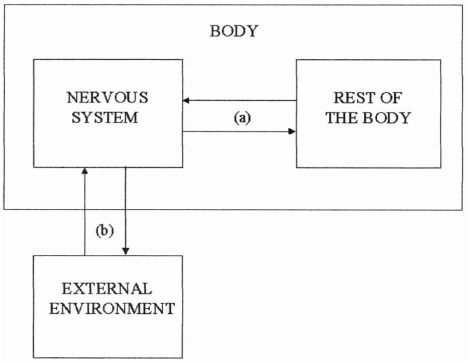
Figure 2. As a physical system the nervous system affects and is affected by two components of the environment that lies outside itself: ( a ) the environment inside the organism’s body (internal environment) and ( b ) the environment that lies outside the organism’s body (external environment). Image taken by [37]. ©Taylor & Francis